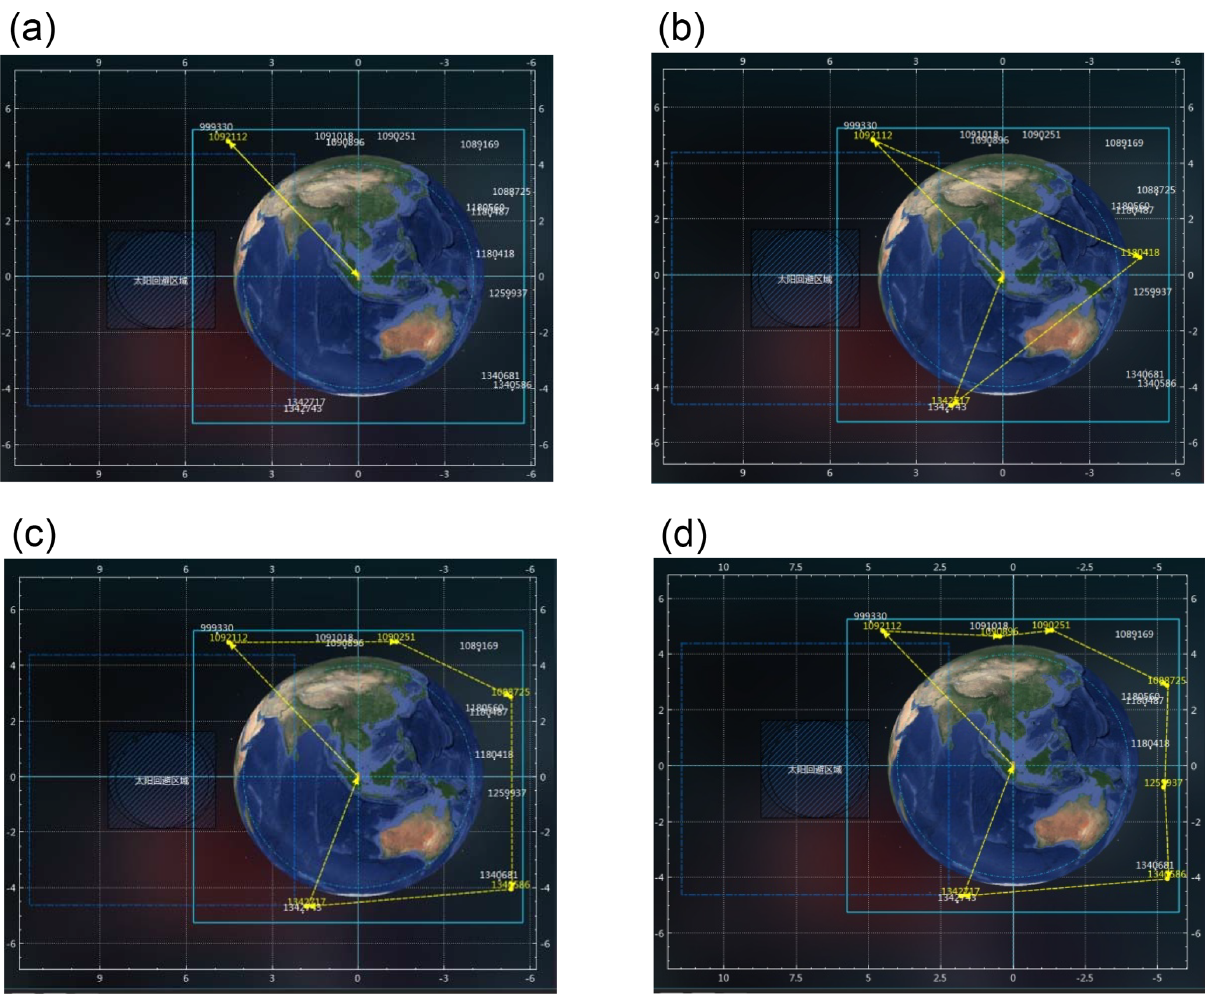
Figure 10. AGRI star selection results – with the sun: (a) the result of choosing one star, (b) the result of choosing three stars, (c) the result of choosing five stars and (d) the result of choosing seven stars.